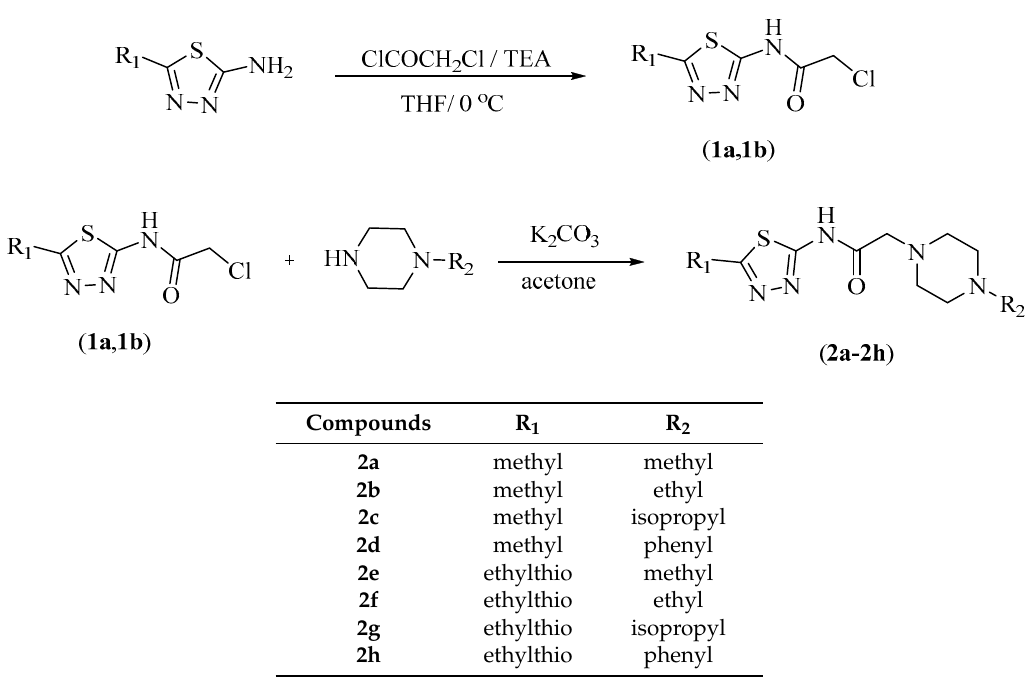
Figure 1. Synthesis pathway of target compounds.